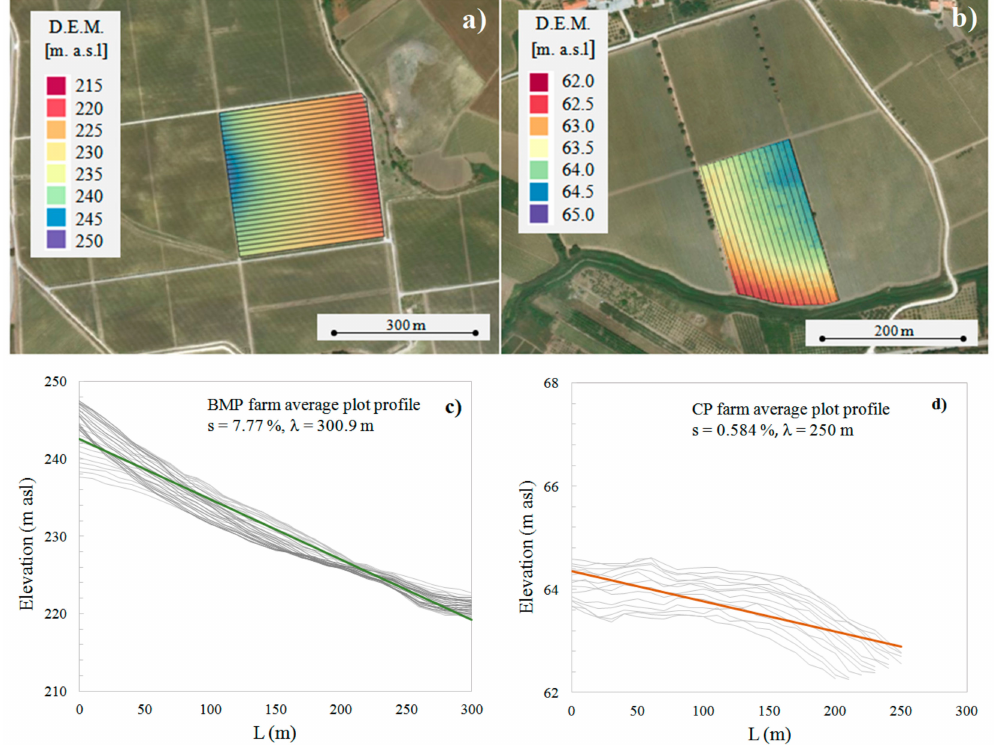
Figure 4. Elevation and topographic attributes of the two vineyards plots. ( a ) BMP farm, ( b ) CP farm, ( c ) BMP farm average profile, ( d ) CP farm average